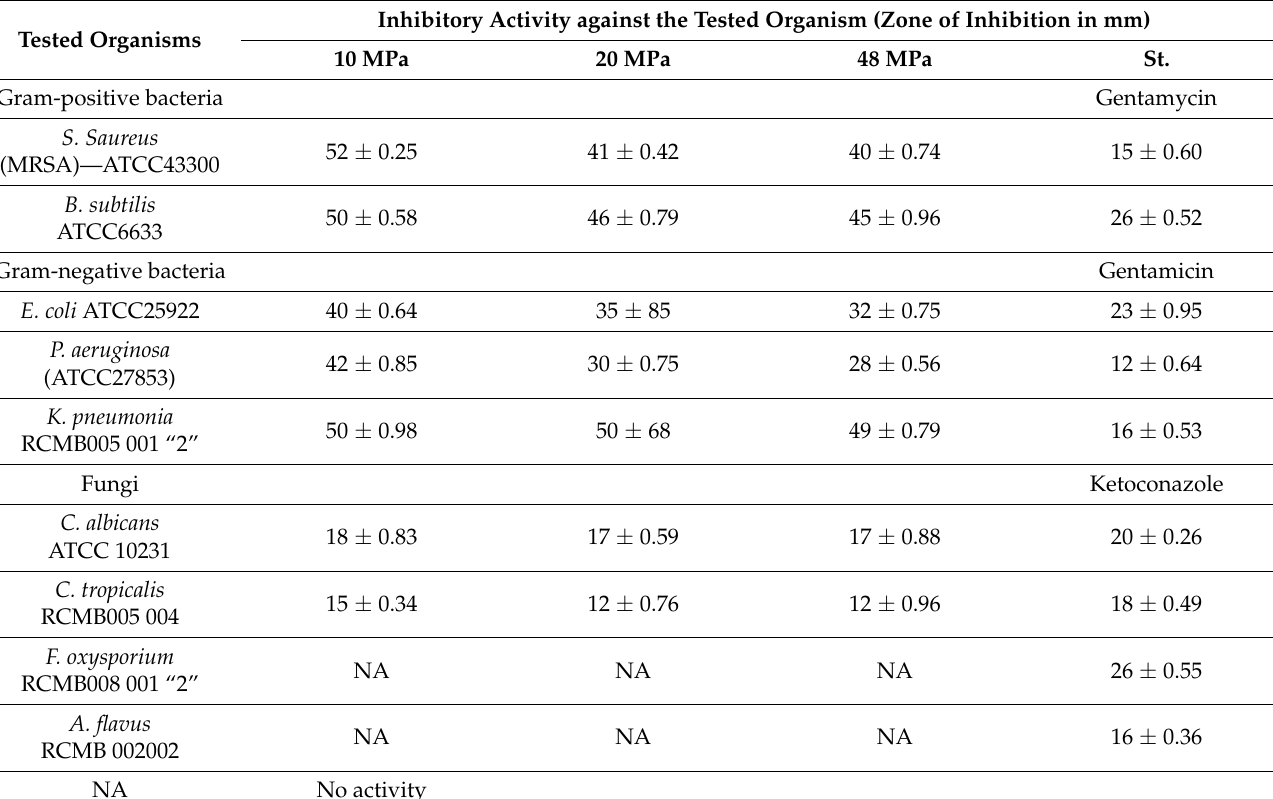
Table 2. Antimicrobial activities of S. costus extract by SFE at different